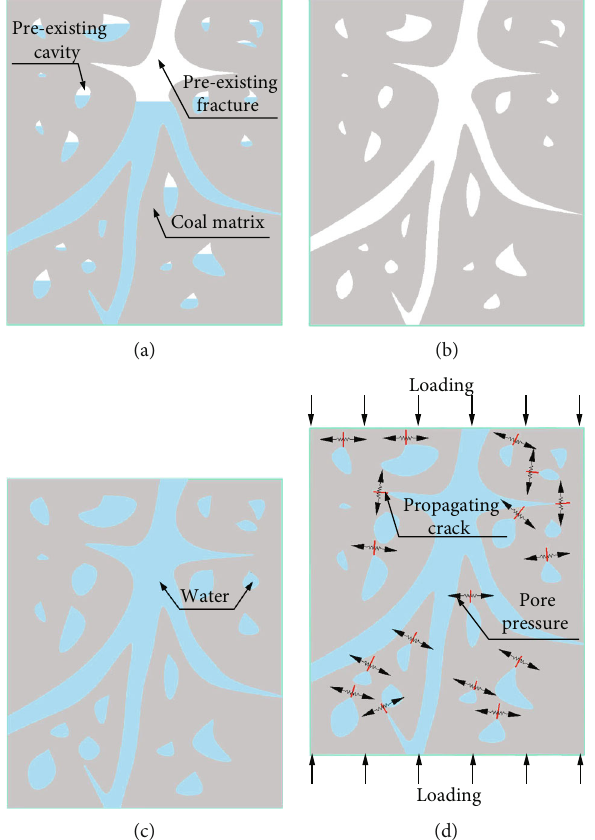
Figure 12: Micromechanical behavior diagram of a water-bearing coal specimen: (a) primary structure of natural coal specimen, (b) coal specimen drying treatment, (c) coal specimen immersion treatment, and (d) applying a